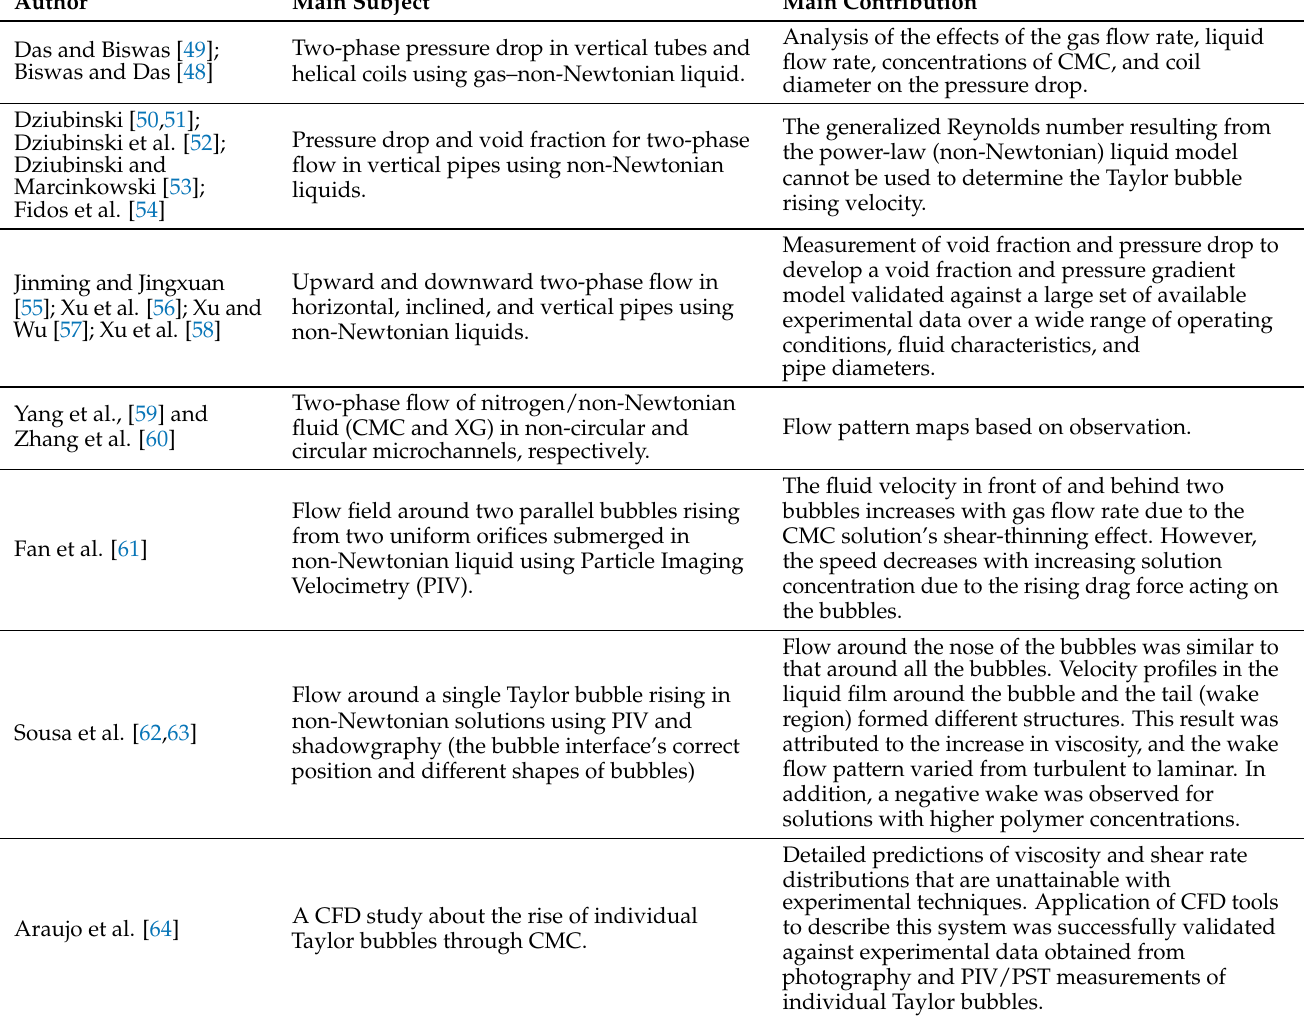
Table 2. Applications of CMC and XG in two-phase flow in